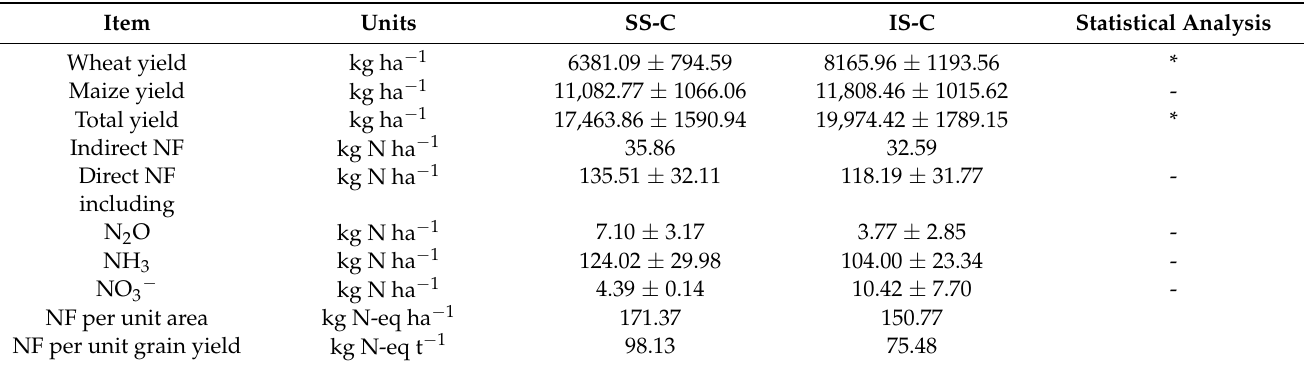
Table 3. NF of crop production subsystem. SS-C is the crop production of separated system, IS-C is the crop production of crop-swine integrated system.